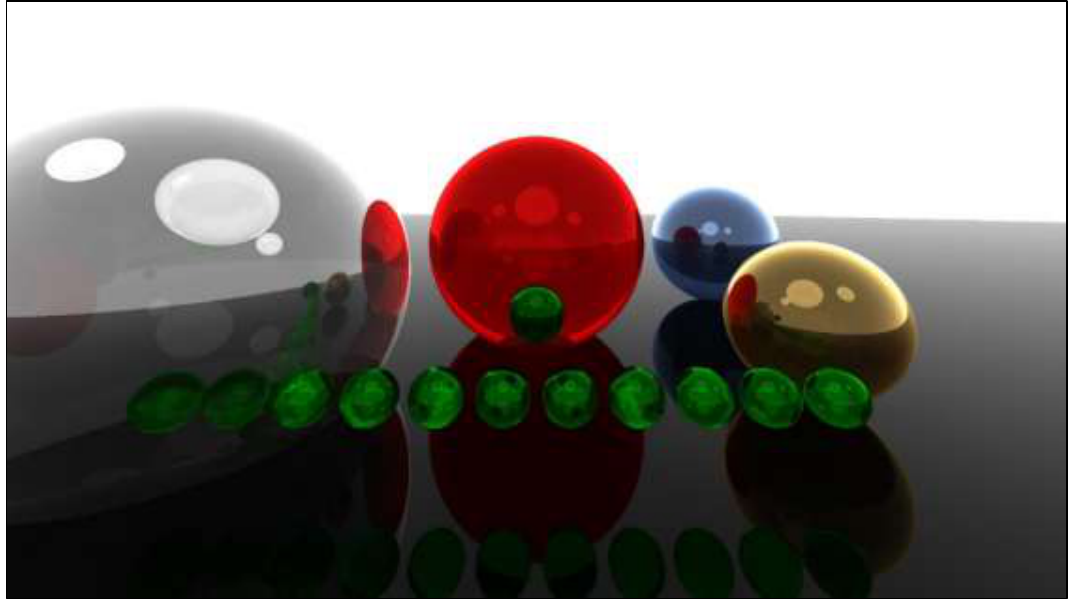
Figure 5. Image created from 19 spheres and a light source with a depth of 8 reflection in 1080p